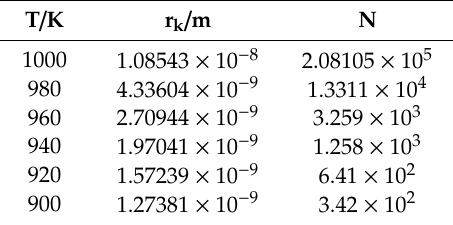
Table 2. Nucleation radius and number of atoms required for nucleation (1473 K heating, 0.2 m 3 / h Ar, 900–1000 K).